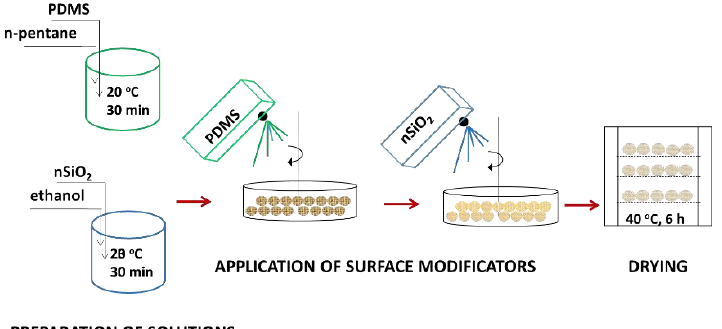
Figure 1. Scheme of preparation of hydrophobized pine sawdust.